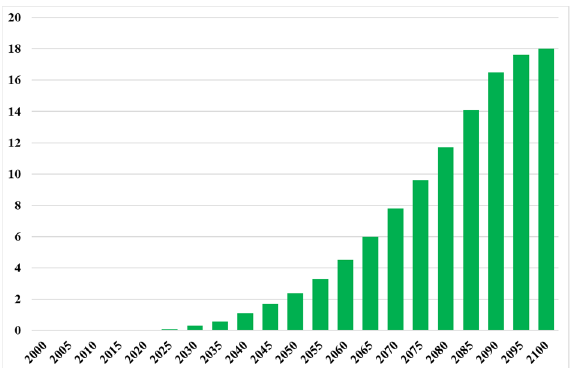
Figure 15. The share of green hydrogen (%) in the structure of the world fuel and energy balance for the 21st century (ambitious scenario) (calculated by authors).